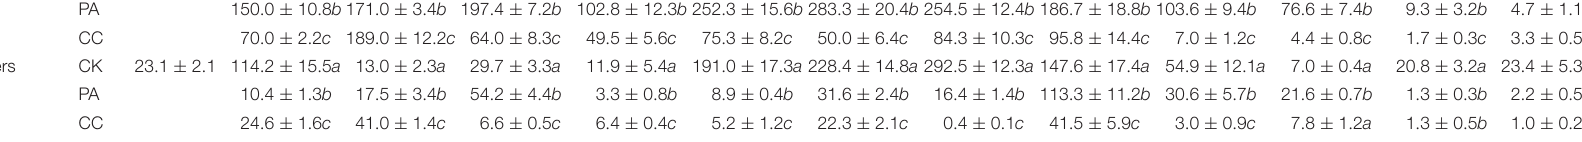
∗ ND, not detected. Different lowercase letters in each column indicate a significant (P < 0.05). CK, control group; PA, propionic acid treated group; CC, essential oils treated